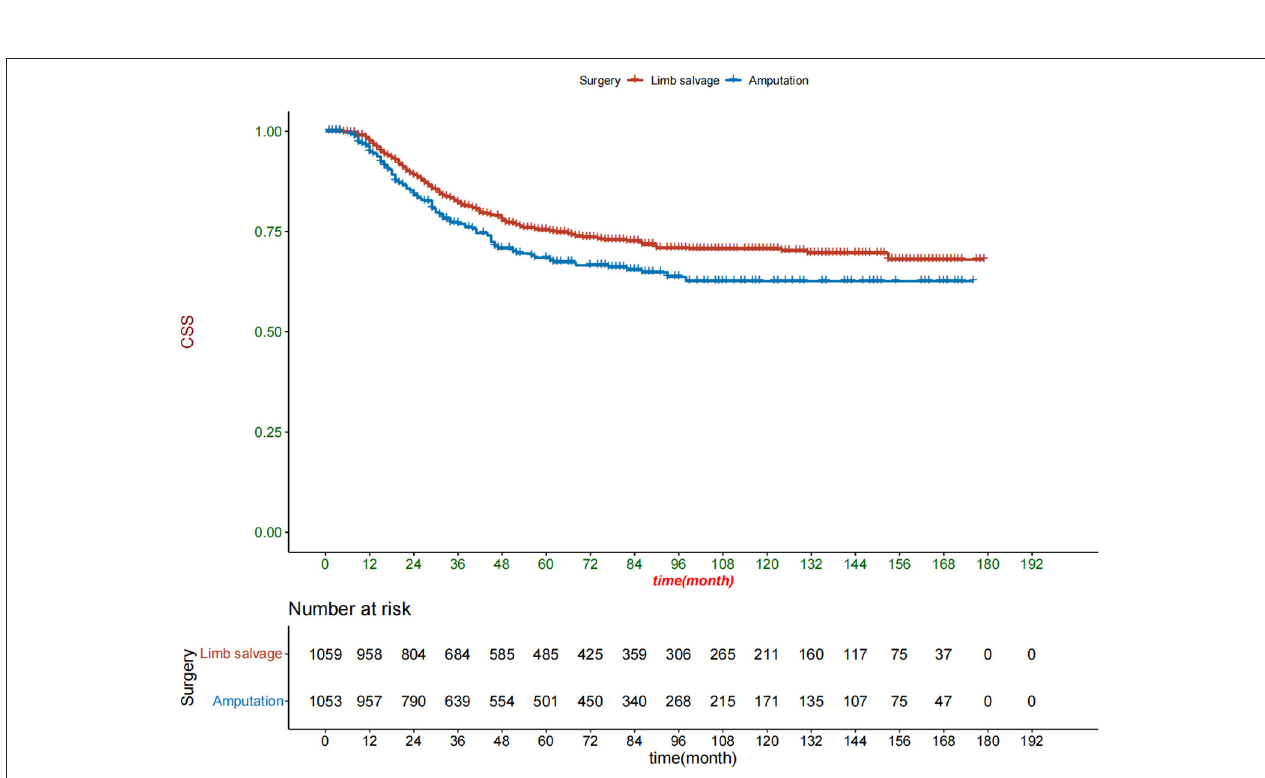
FIGURE 6 | Kaplan-meier curve of patients receiving amputation and limb salvage after the inverse probability of treatment weighting matching.